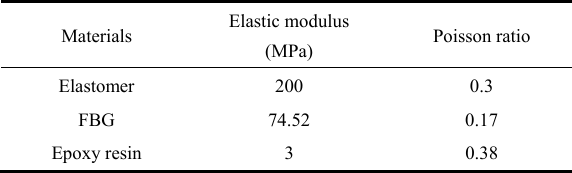
Table 2 Material